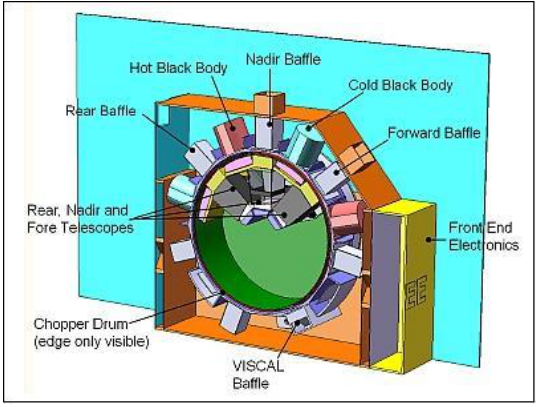
Figure 11. Diagram showing Broadband Radiometer (BBR) optics unit